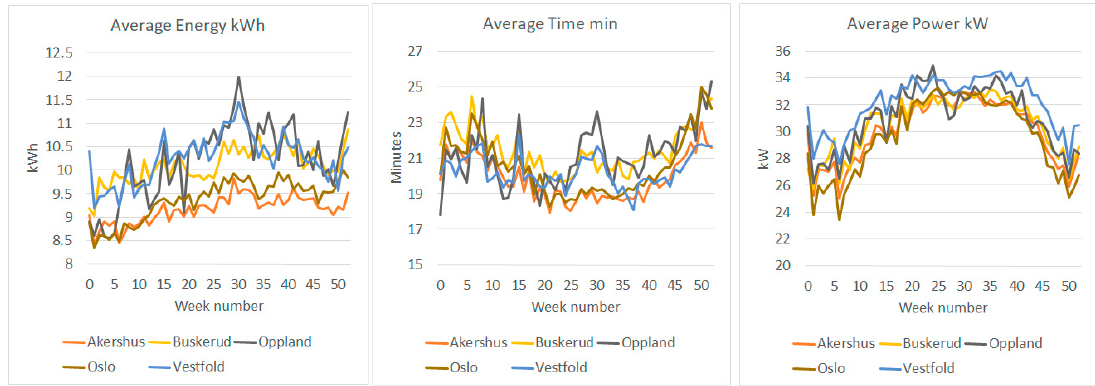
Figure 14. Average energy charged, time used and average power of fast charging in Counties in Norway in 2017. Source: Dataset 1 and own analysis.